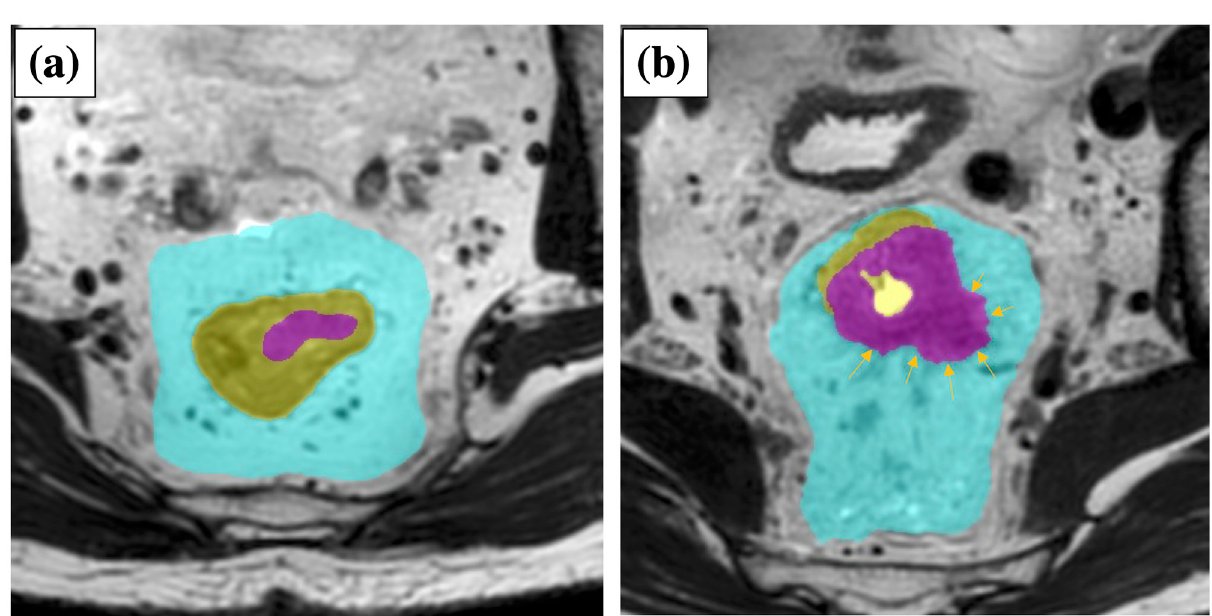
Fig 4. Staging algorithm. Left, T2 case, and right, T3 case. The magenta, yellow, and cyan areas represent tumor, rectum and mesorectum, respectively.